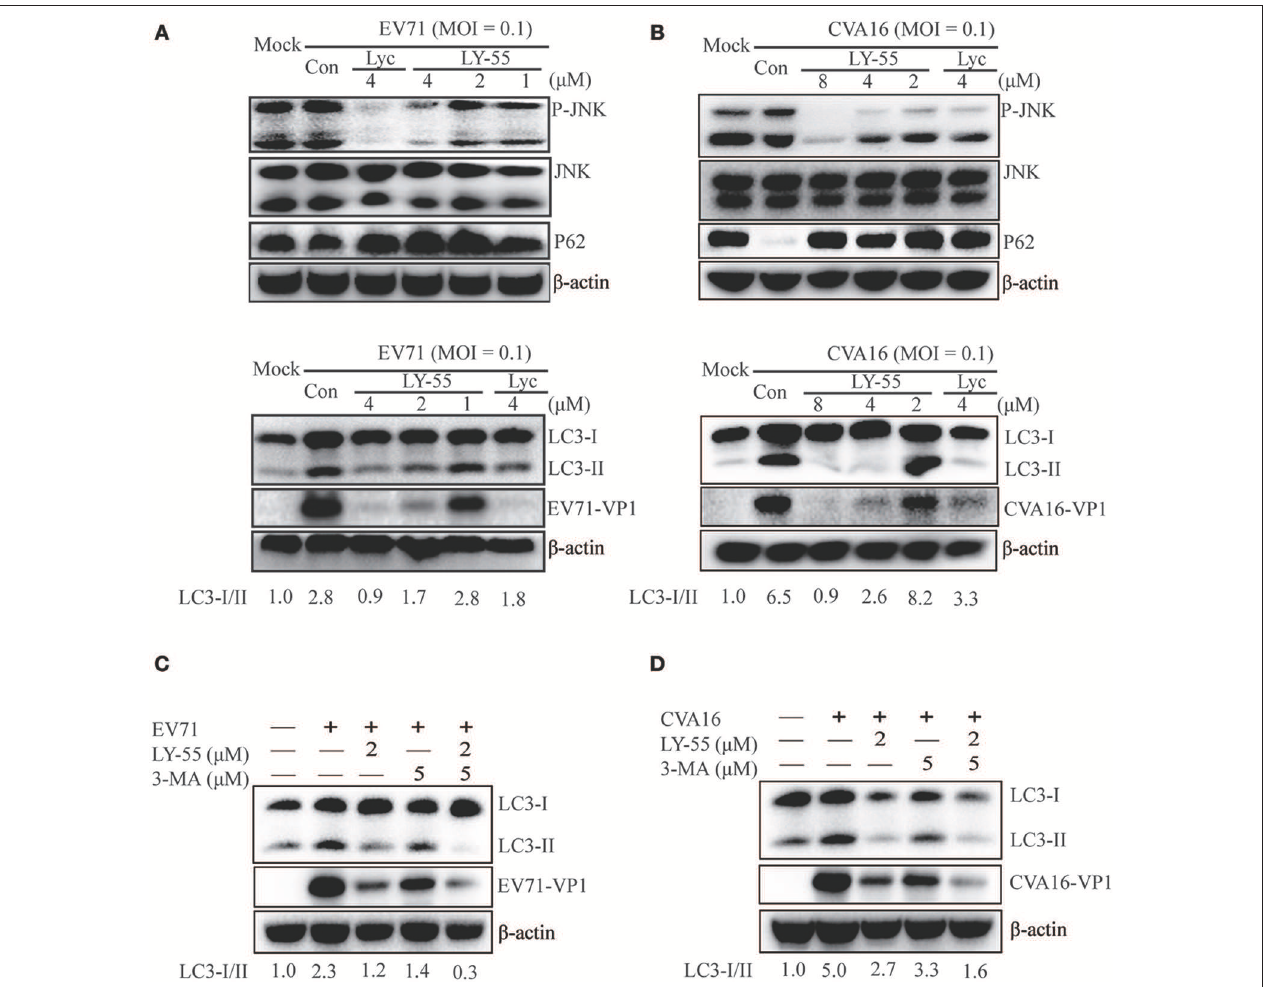
FIGURE 4 | LY-55 could inhibit autophagy induced by EV71 and CVA16 infection. (A,B) LY-55 and lycorine can reduce EV71 and CVA16 induced autophagy. Vero cells mock-infected or infected with EV71 or CVA16 (MOI = 0.1) for 1h. Cells were treated with LY-55 and lycorine for 24h. Cells were harvested, and the proteins were examined by using Western blot analysis. (C,D) LY-55 and 3-MA could synergistically inhibit virus replication through inhibiting autophagy. Vero cells mock-infected or infected with EV71 or CVA16 (MOI = 0.1) for 1h. Cells were treated with LY-55 and 3-MA for 24h. Cells were harvested, and the proteins were examined by using Western blot analysis. Sorfware “Gel-Pro analyzer” was used to analysis of the optical density ratio of the bands.